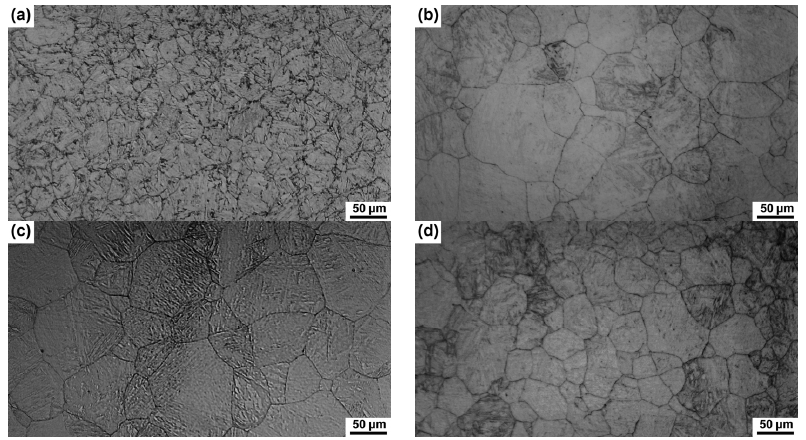
Figure 4. TP = 1200 °C. Grain morphology at different t 8/5 time: ( a ) Original, ( b ) 20 s, ( c ) 50 s, ( d ) 100 s.